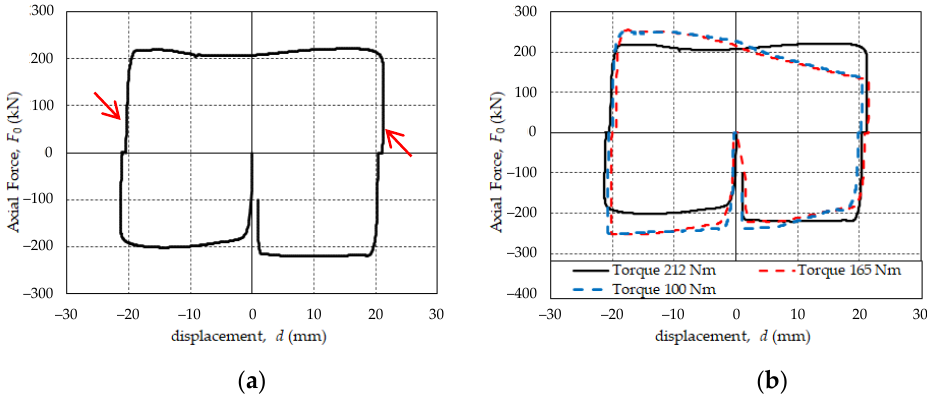
Figure 7. Hysteresis loops of the PS-LED prototype: ( a ) regular loop of the prototype with fixing screws tightened to 212 Nm [41]; ( b ) deformed loop with trailing void for low tightening torque.